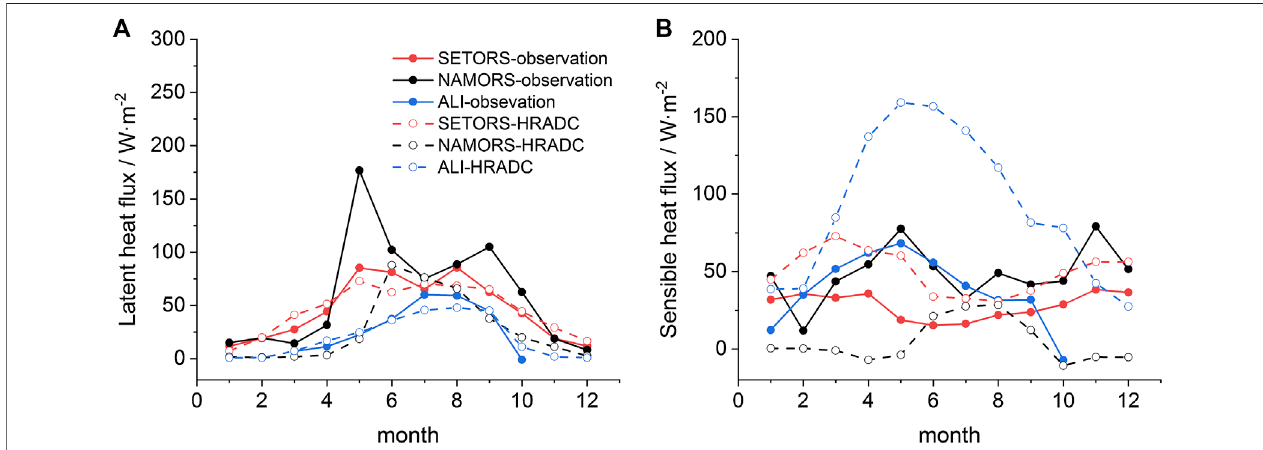
FIGURE 8 | Comparison of monthly averaged observations and High-Resolution Assimilation Dataset of the Water-Energy Cycle in China simulations, from three fl ux stations in Qinghai-Tibet Plateau, (A) latent heat fl ux and (B) sensible heat fl ux (Unit: W · m − 2 ).